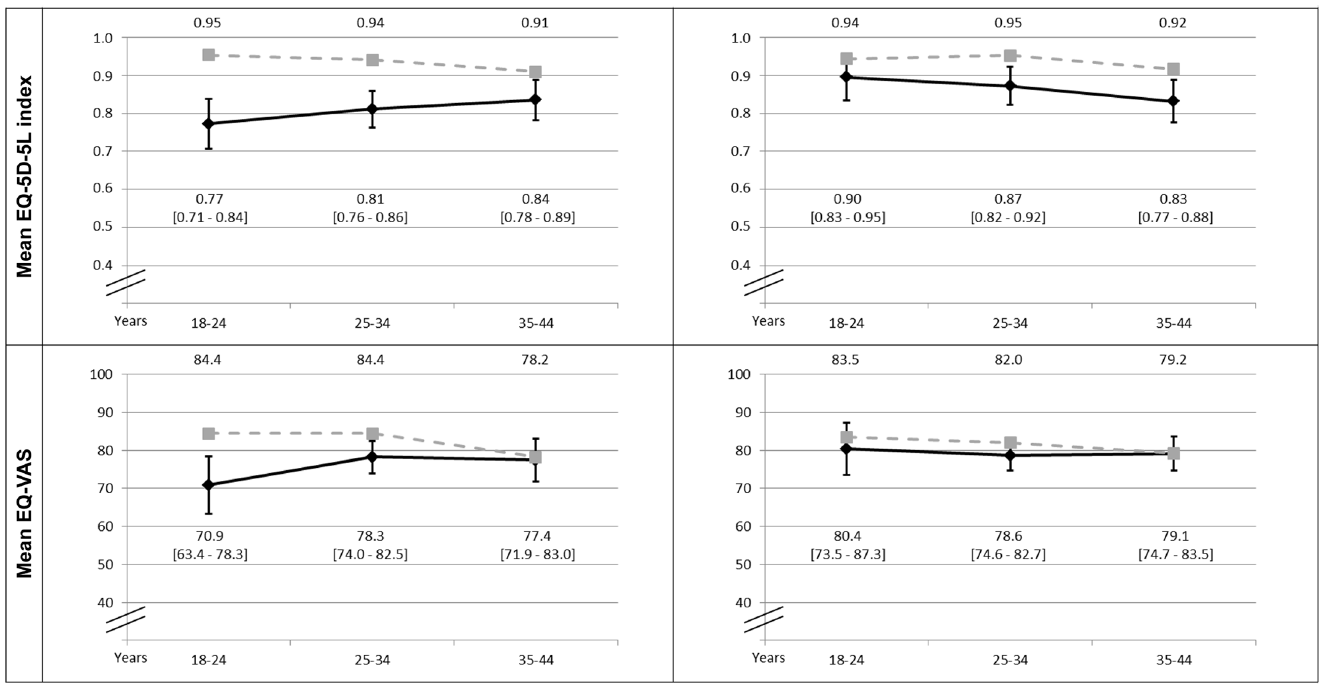
Fig 1. EQ-5D index and EQ-VAS: comparison between patients with asthma and French general population-based reference norms. Mean and 95% Confidence Interval (95%CI) of EQ-5D index and EQ-VAS in patients with asthma stratified by age and gender (in black). Grey dotted line represents the mean in French general population-based reference norms